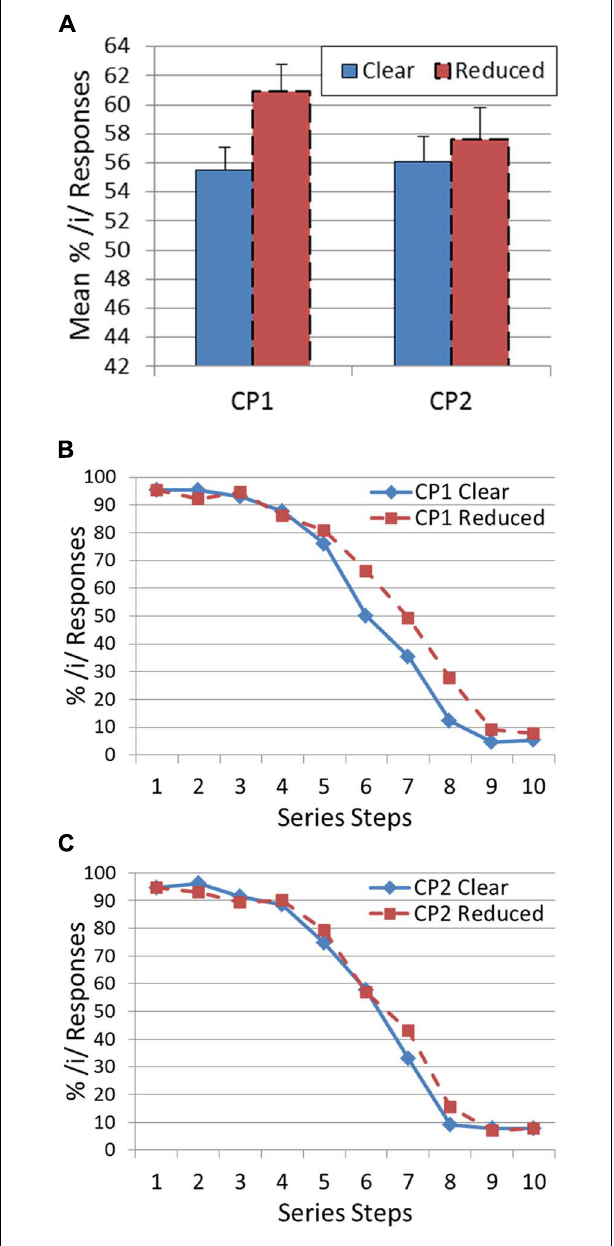
FIGURE 1 | Results of Experiment 1: (A) Histogram showing mean percentage of /i/ responses for CP1 and CP2 for both a clear and reduced speaking style. Error bars indicate standard error of the mean. (B) Categorization function showing mean percentage of /i/ responses across vowel series from /i/ to /I/ for CP1. Speaking style is represented by a different line. (C) Categorization function showing mean percentage of /i/ responses across vowel series from /i/ to /I/ for CP2. Speaking style is represented by a different